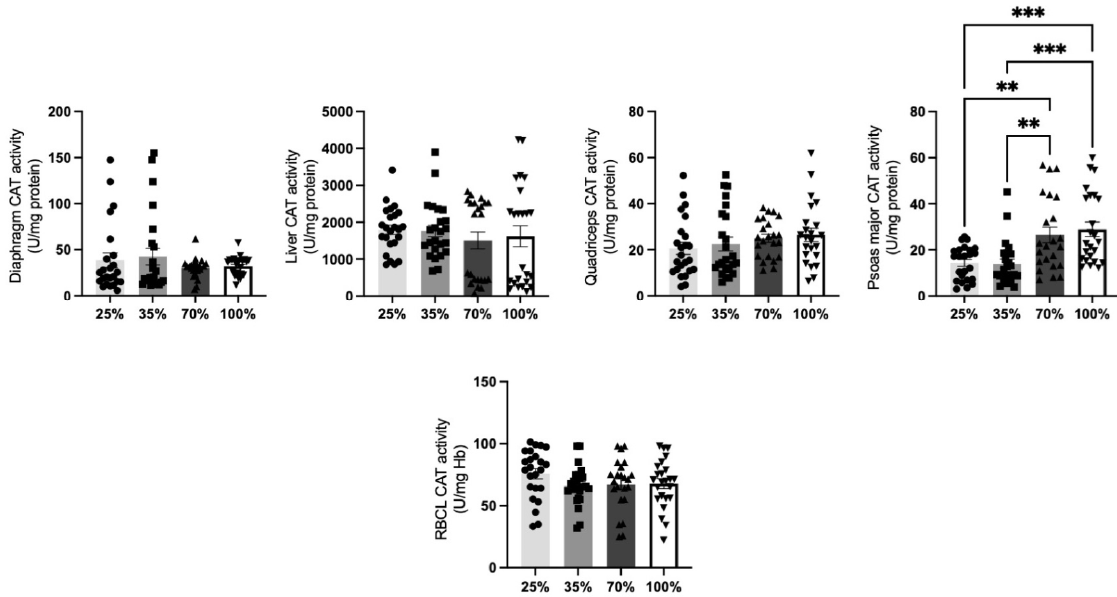
Figure 4. CAT activity levels at all 4 d.s of lamb . ** denotes significant difference with p < 0.01, *** denotes significant difference with p < 0.001. *** denotes significant difference with p <